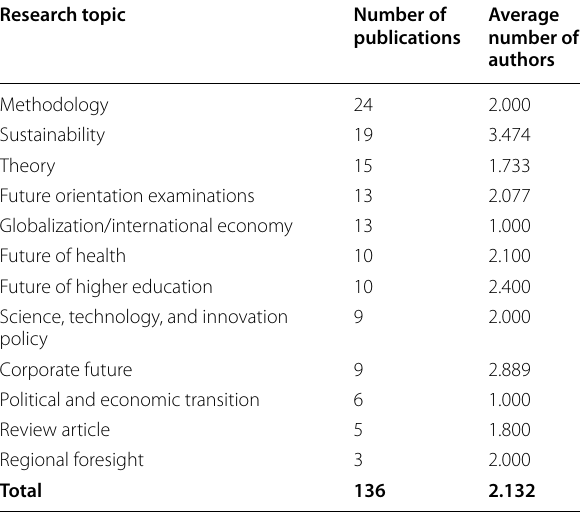
Table 2 Distribution of articles per research topic